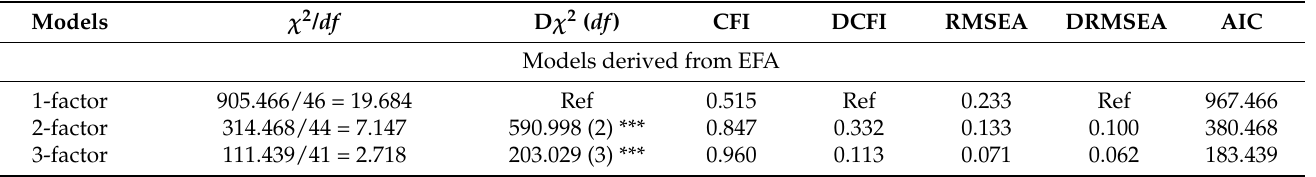
Table 4. Comparison of EFA-derived factor models ( n = 347).